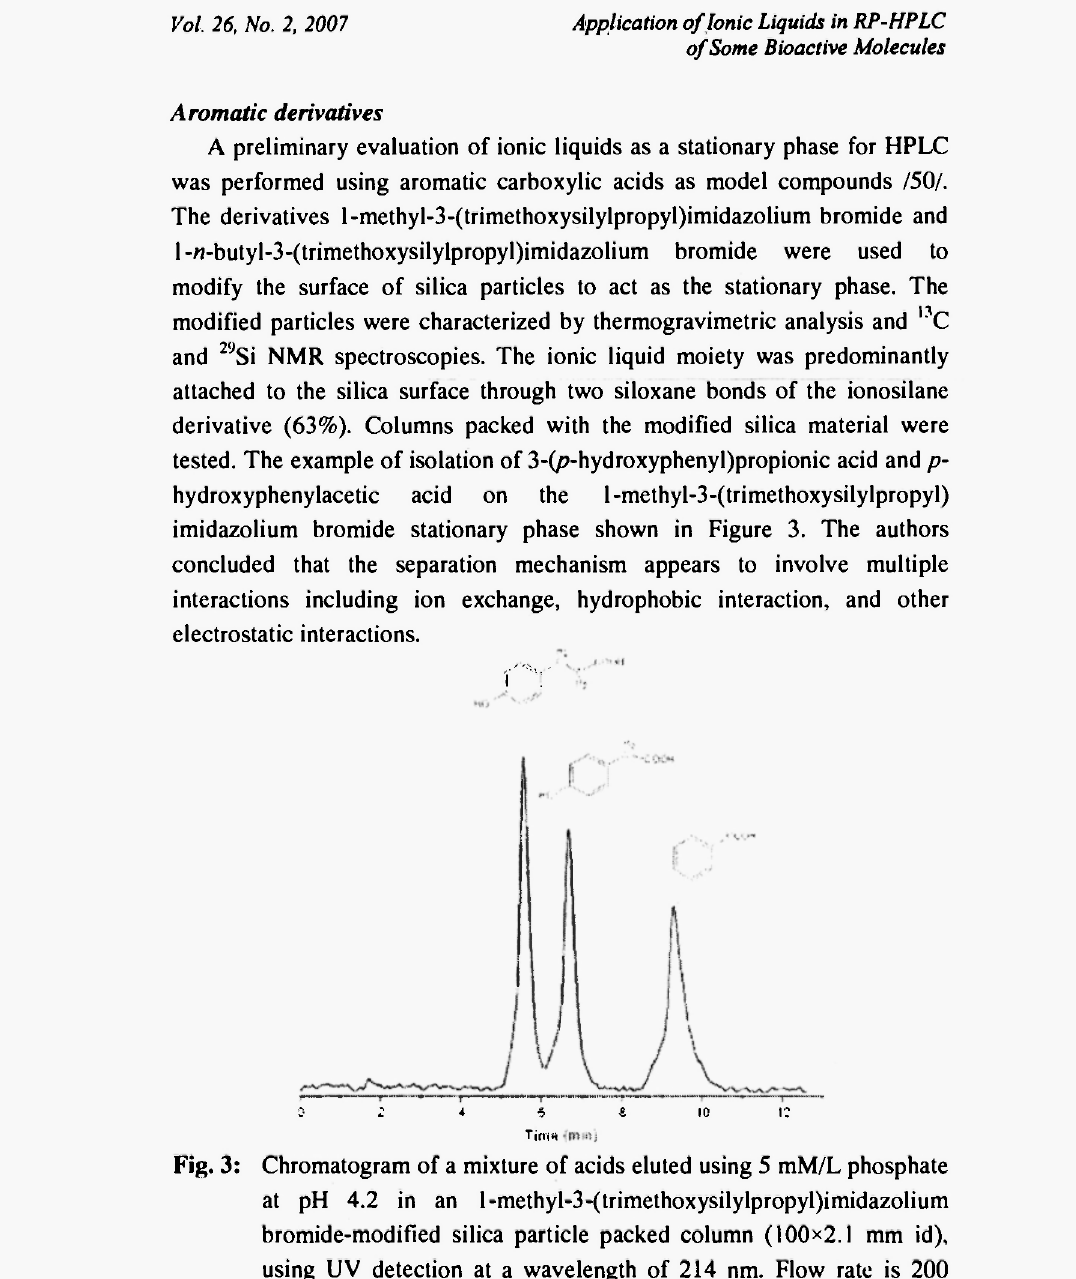
Fig. 3: Chromatogram of a mixture of acids eluted using 5 mM/L phosphate at pH 4.2 in an l-methyl-3-(trimethoxysilylpropyl)imidazolium bromide-modified silica particle packed column (Ι00 χ 2.1 mm id), using UV detection at a wavelength of 214 nm. Flow rate is 200 μίνπιιη. Peaks, from left to right: 3-(^-hydroxyphenyl)propionic acid, p-hydroxyphenylacetic acid, and benzoic acid (reprinted with permission from Ref.